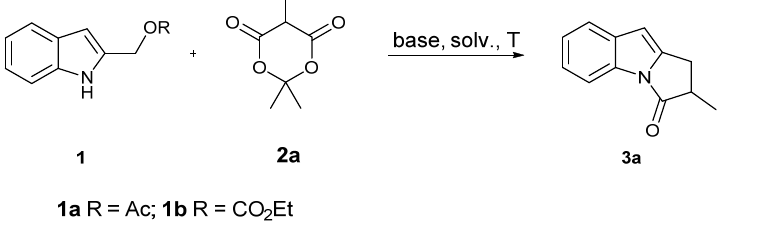
Table 1. Optimization studies for the reaction of 1 with methyl Meldrum’s acid 3a . a